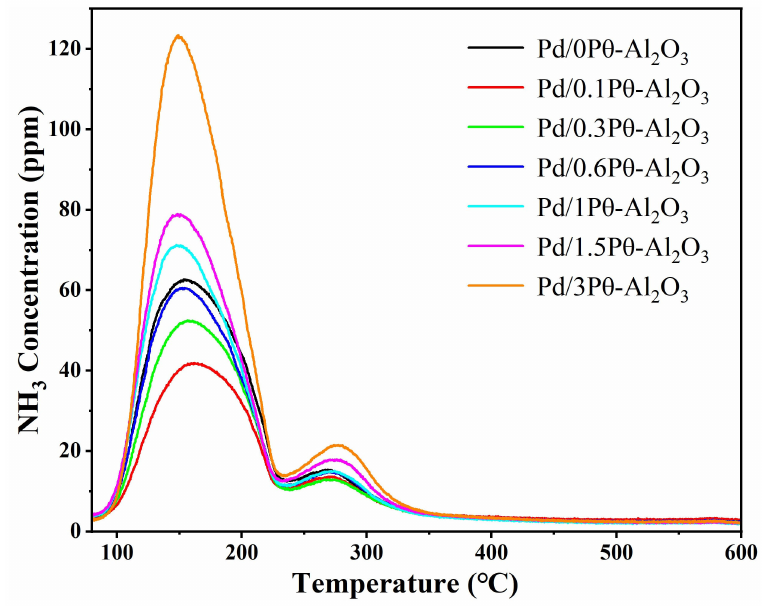
Figure 9. NH 3 -TPD profiles of the